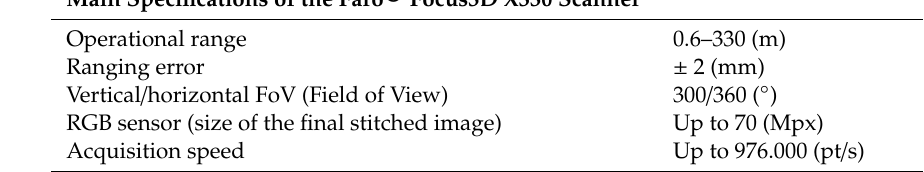
Table 3. Main specifications of the Faro ® Focus3D X330 scanner used for the Terrestrial Laser Scanning (TLS) survey.